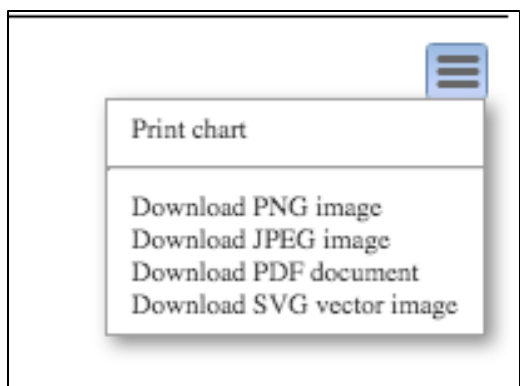
6. Click to print or to save the innovation map as the form that user will be choose.